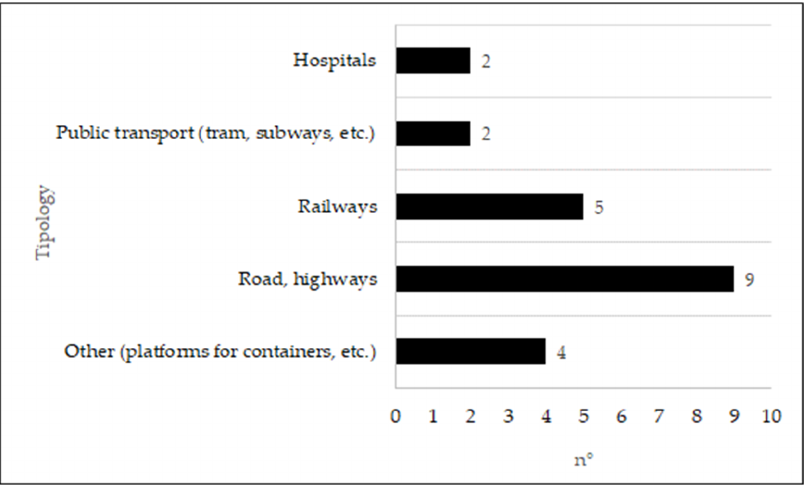
Figure 2. Typologies of infrastructure projects in the Liguria